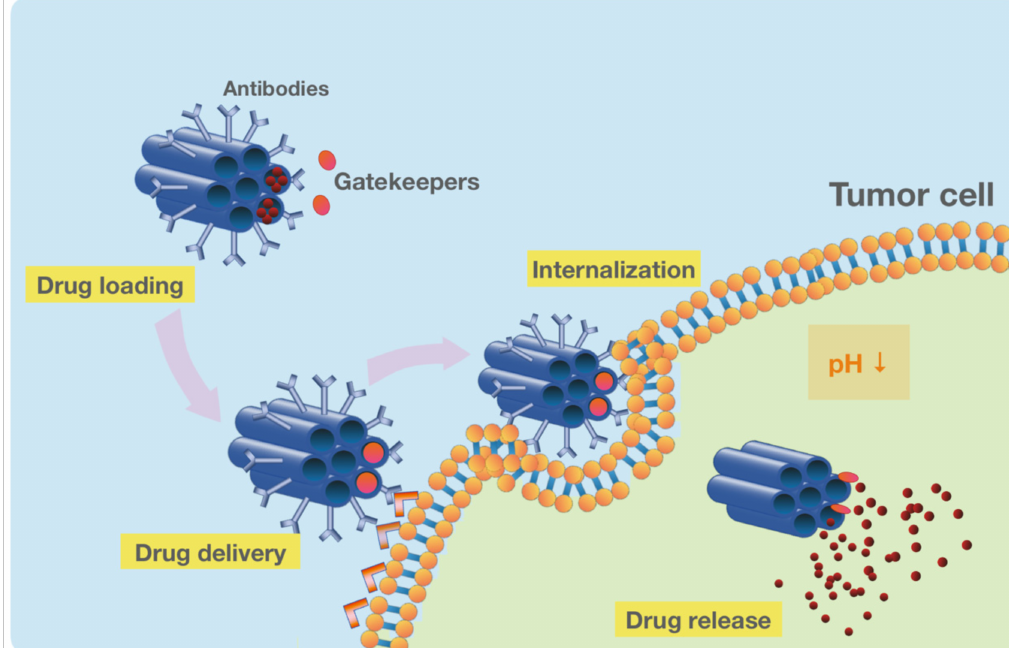
Figure 4. The functionalized MSNs for the targeted drug delivery and release in tumor cells. The pH-sensitive drug- loaded MSNs are conjugated with an antibody to target cancer cells specifically. After the delivery and internalization of MSNs, the pH-sensitive gatekeepers release the drug in response to the acidic tumor